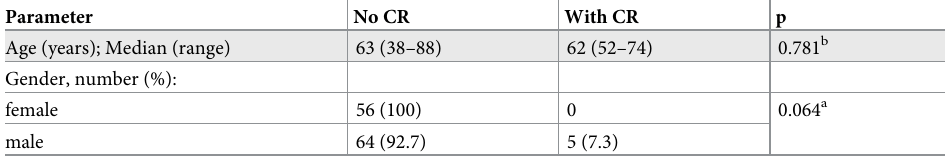
Table 4. Associations between Cryptosporidium spp. infection (CR) and age and gender, in the control group (n = 125). Parameter